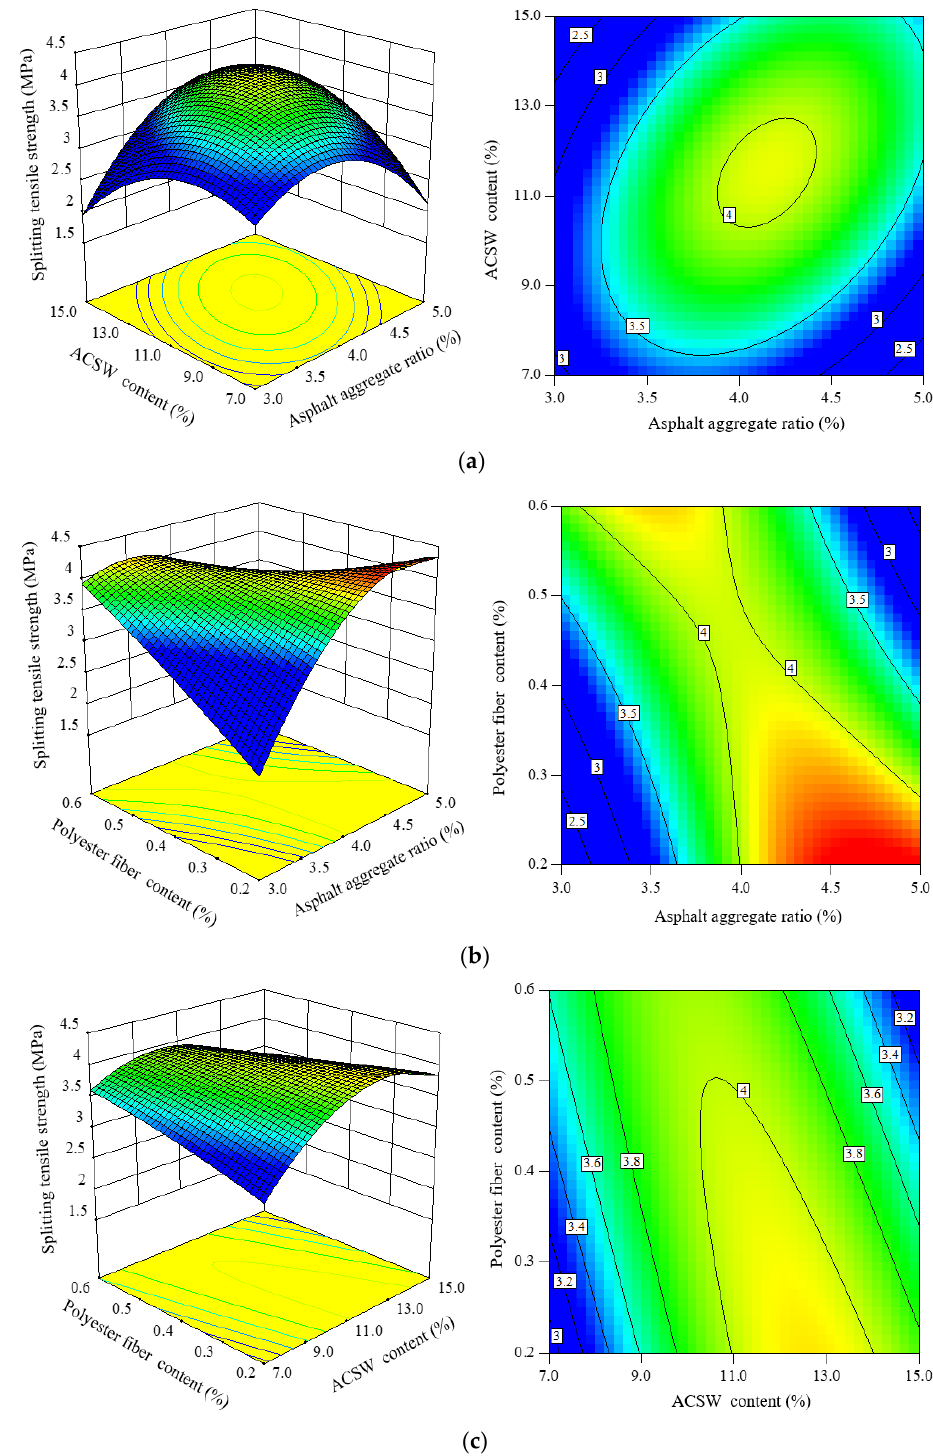
Figure 8. Three- and two-dimensional CCC response maps among three factors on STS : ( a ) factors: asphalt aggregate ratio and ACSW content; ( b ) factors: asphalt aggregate ratio and polyester fiber content; and ( c ) factors: ACSW content and polyester fiber content.